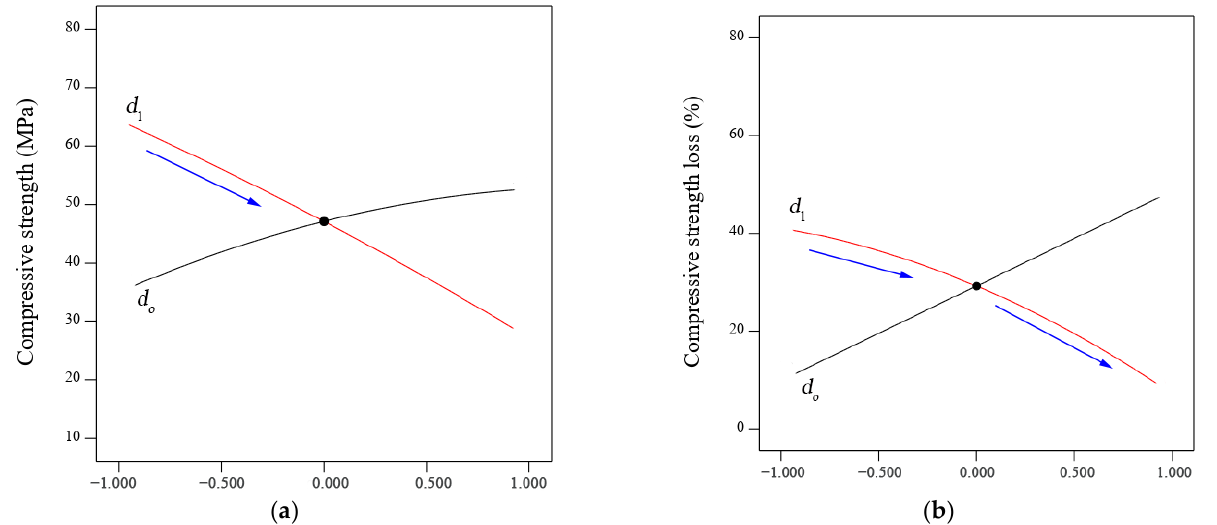
Figure 3. Perturbation curves for the ( a ) compressive strength of SCAAC (Model 1) and ( b ) strength loss of SCAAC when exposed to acid attack (Model 2).